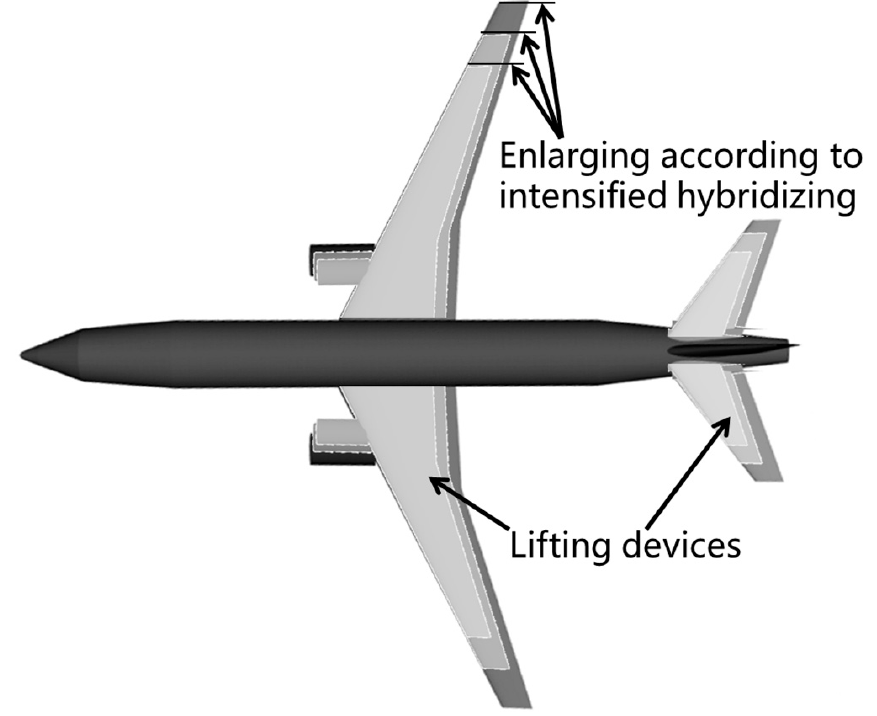
Figure 1. Geometry and dimensional changes of lifting devices in accordance with aerodynamic requirement.